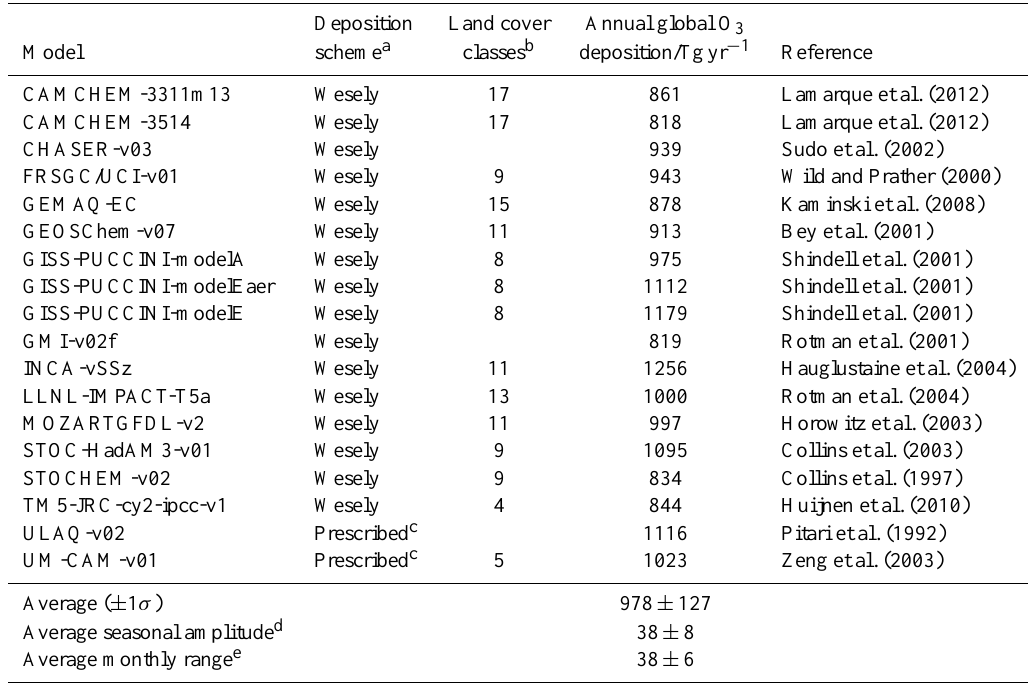
Table 1. Summary of the deposition schemes and annual total global O 3 dry deposition fluxes for 15 TF HTAP